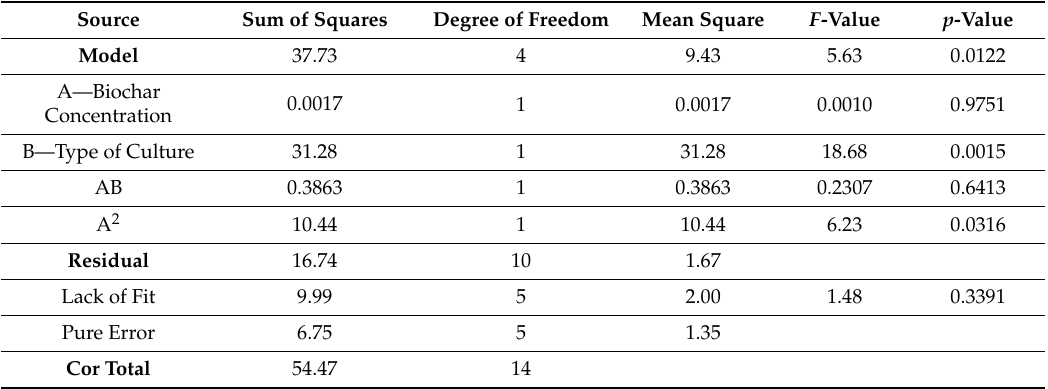
Table A3. Analysis of variance for the two-factor